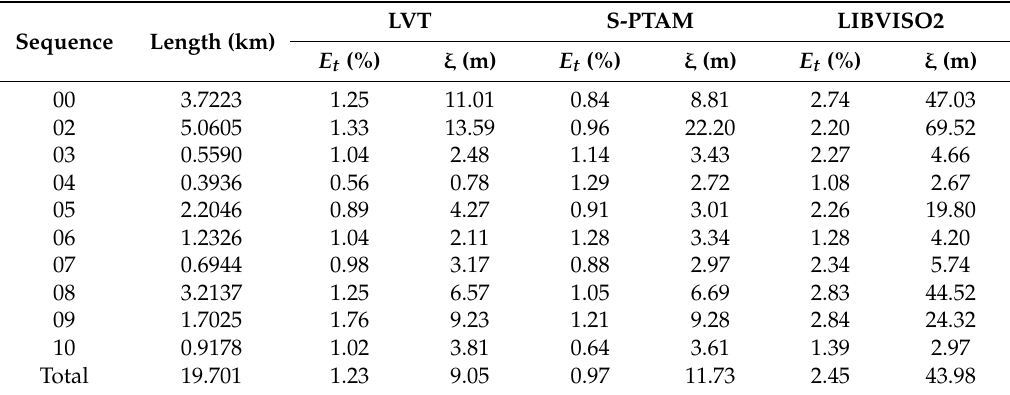
Table 1. Results on KITTI